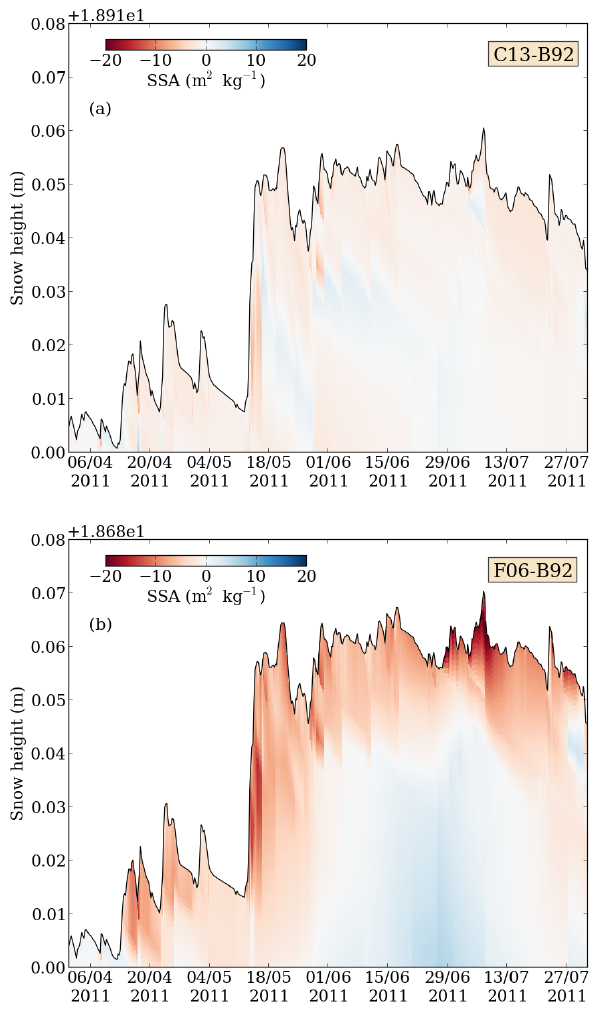
Fig. 7. Comparison in terms of SSA between the metamorphism formulations implemented in Crocus. In order to compare results obtained using different formulations, all SSA profiles were inter- polated over a 1mm vertical grid. The plots show the difference between the new formulations C13 (top) and F06 (bottom) and the original formulation B92, for simulations run at Summit from 1 April to 31 July 2011. different simulations are significantly smaller than those be- tween simulations and observations.